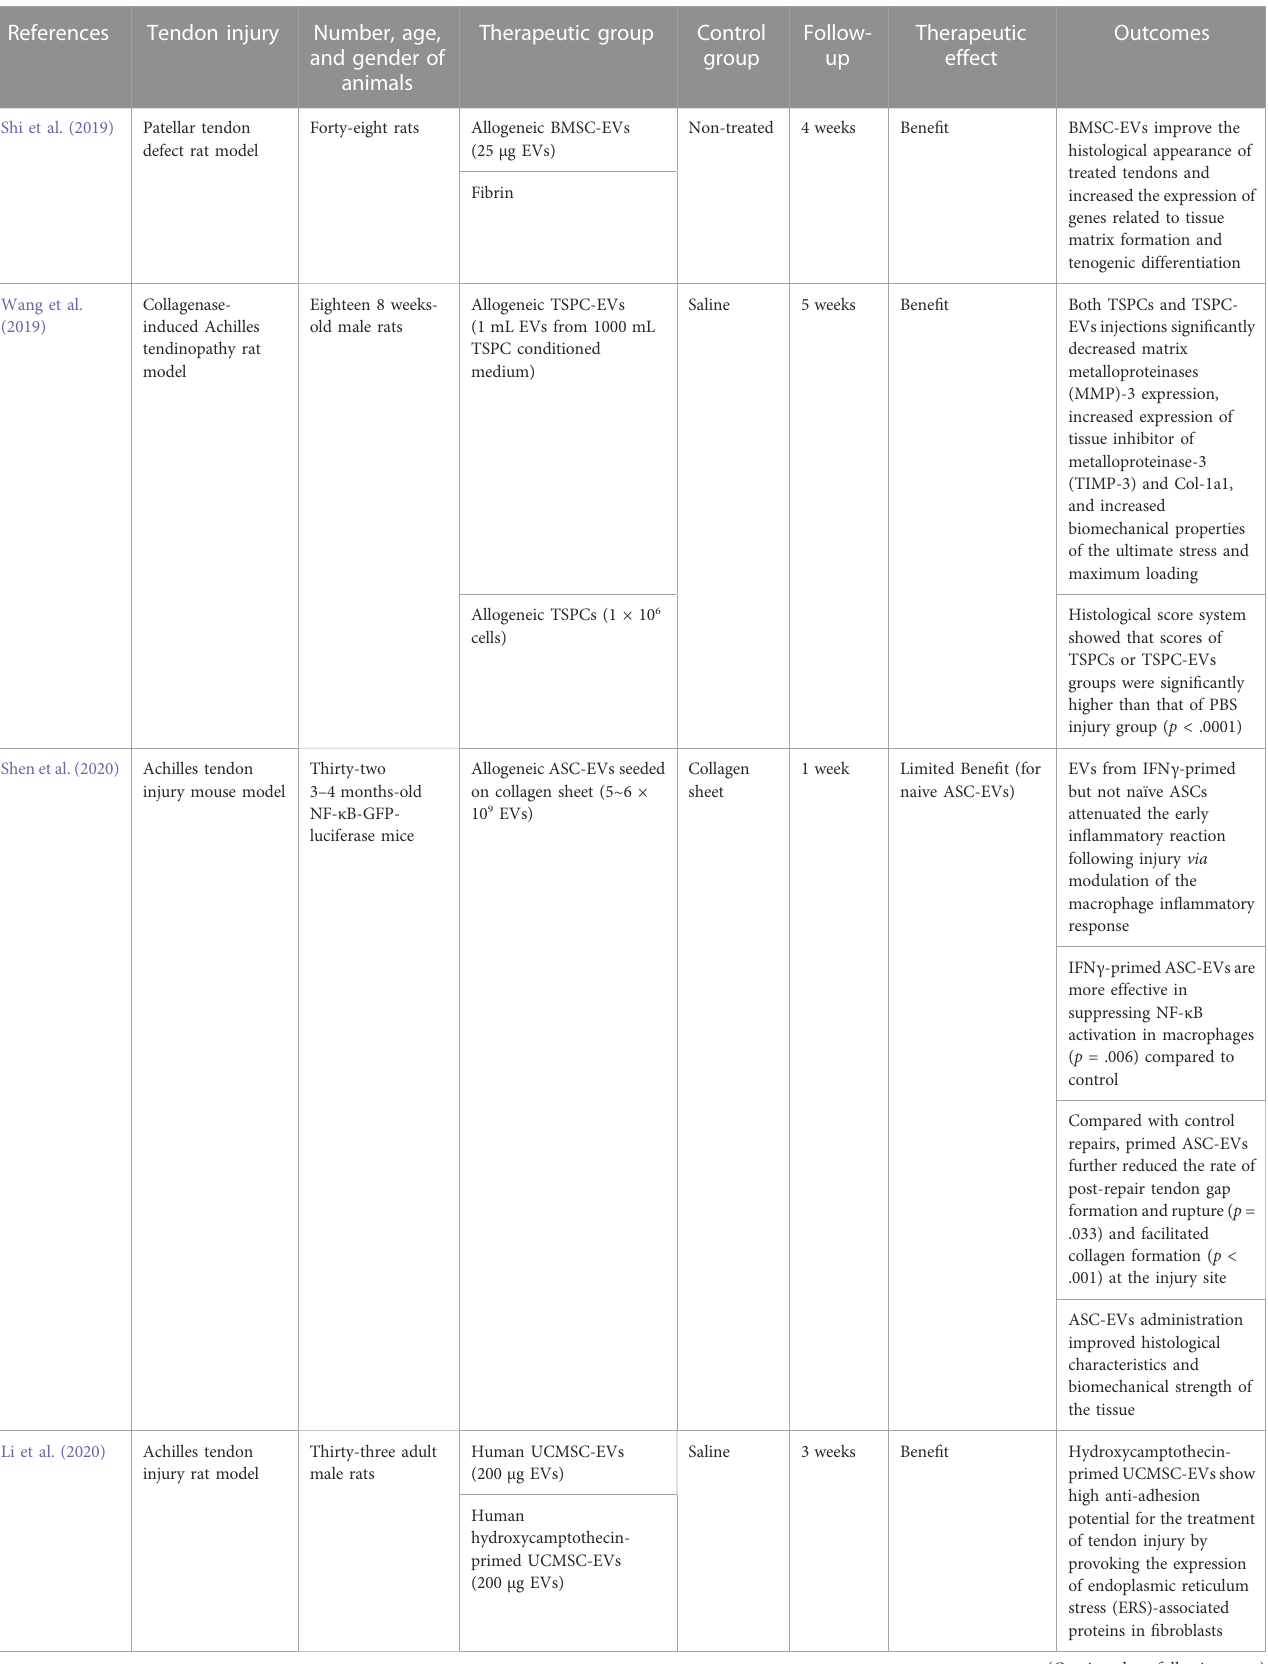
TABLE 3 Immunomodulatory and reparative actions of MSC EVs in preclinical tendinopathy